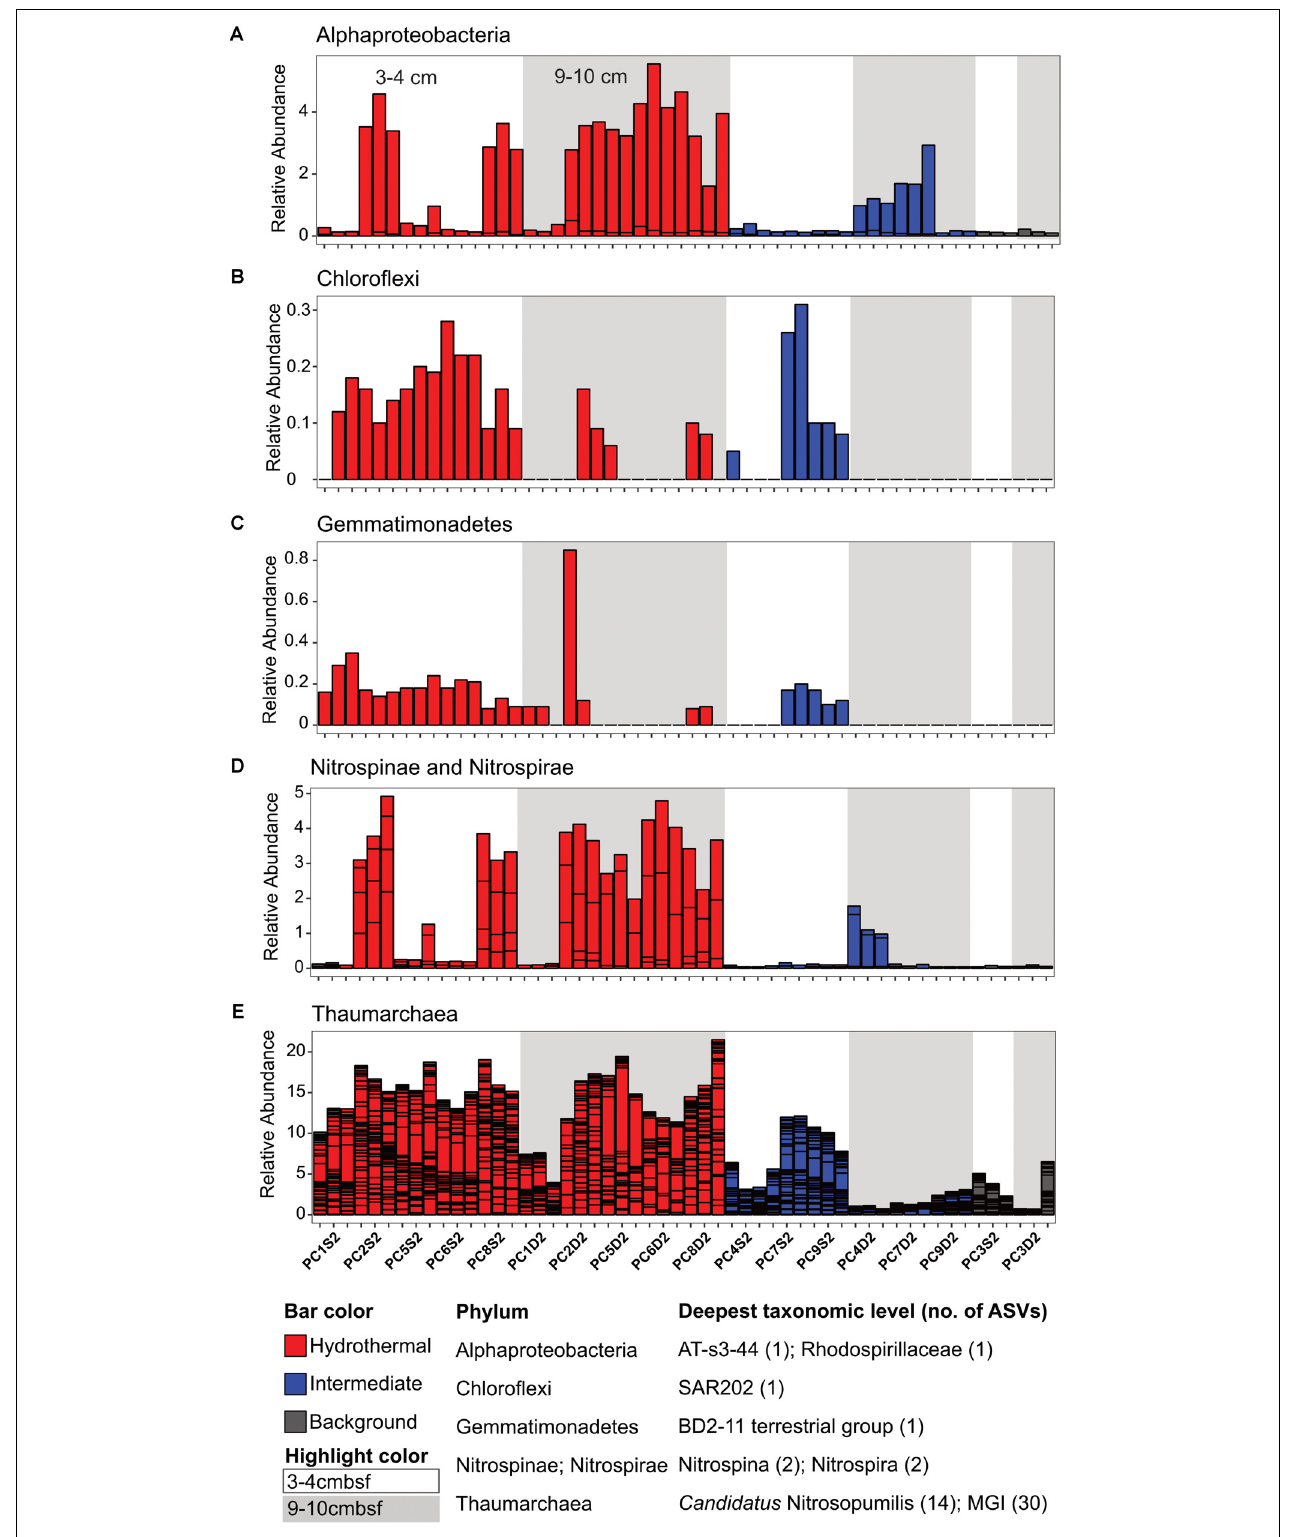
FIGURE 4 | Select ASVs associated with (A) Alphaproteobacteria, (B) Chloroflexi, (C) Gemmatimonadetes, (D) Nitrospinae and Nitrospirae, and (E) Thaumarchaea which were more abundant in the hydrothermal and/or the hydrothermal plus intermediate samples. Bars are colored by sample, and divided by ASV abundance. Relative abundance is in percent of total sequences per sample. The deepest taxonomic level assigned are listed next to the phylum followed by the number of ASVs graphed.